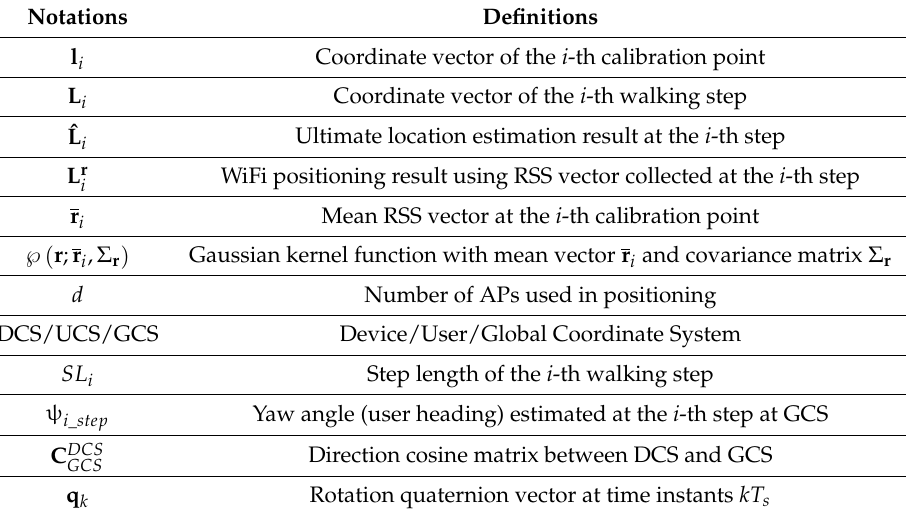
Table 1. Key symbols used in the proposed fusion